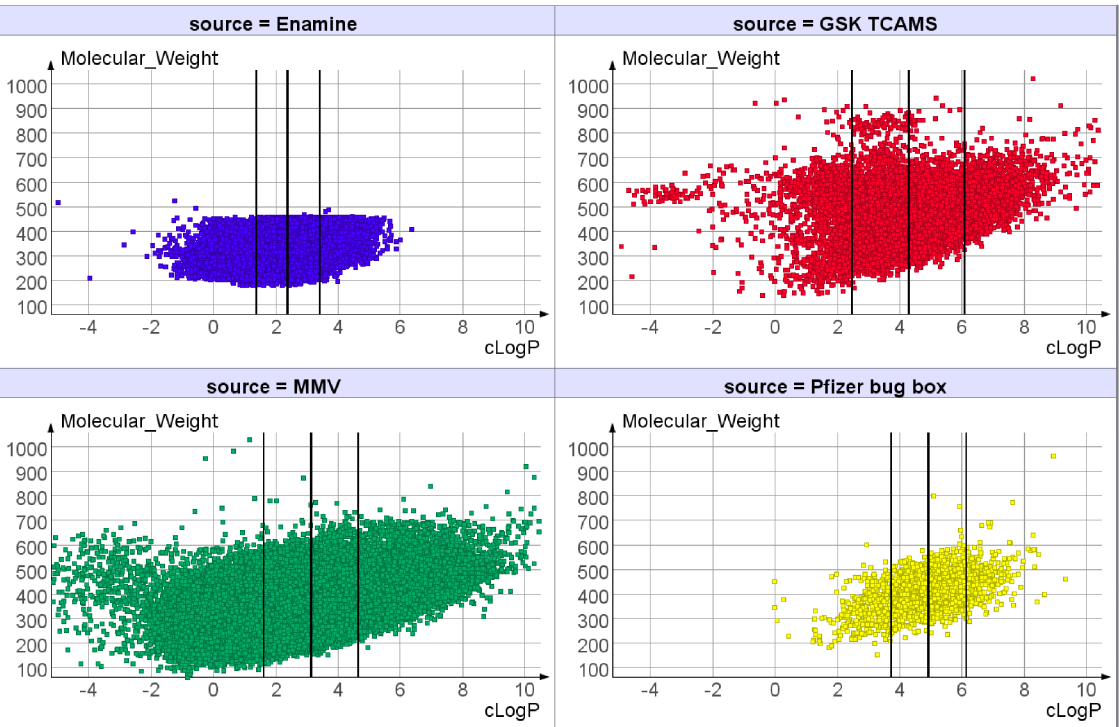
Fig 2. Scatter plots of the screened compound collections with calculated lipophilicity, cLogP using DataWarrior [25] on the X axis vs molecular weight on the Y axis.